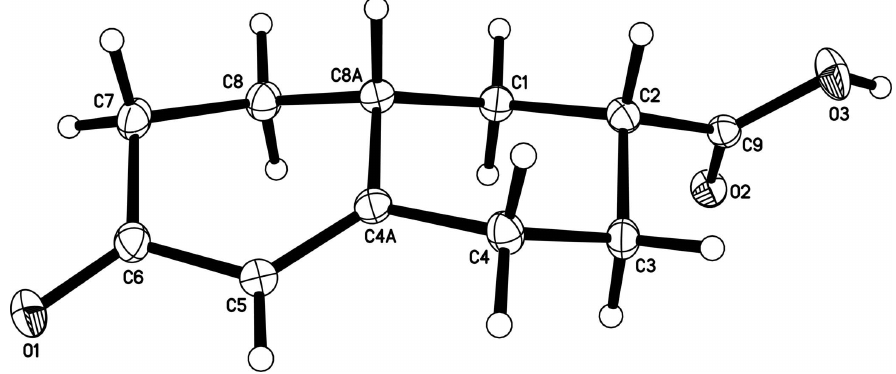
The asymmetric unit of (I), with its numbering. Displacement ellipsoids are drawn at the 40% probability level.